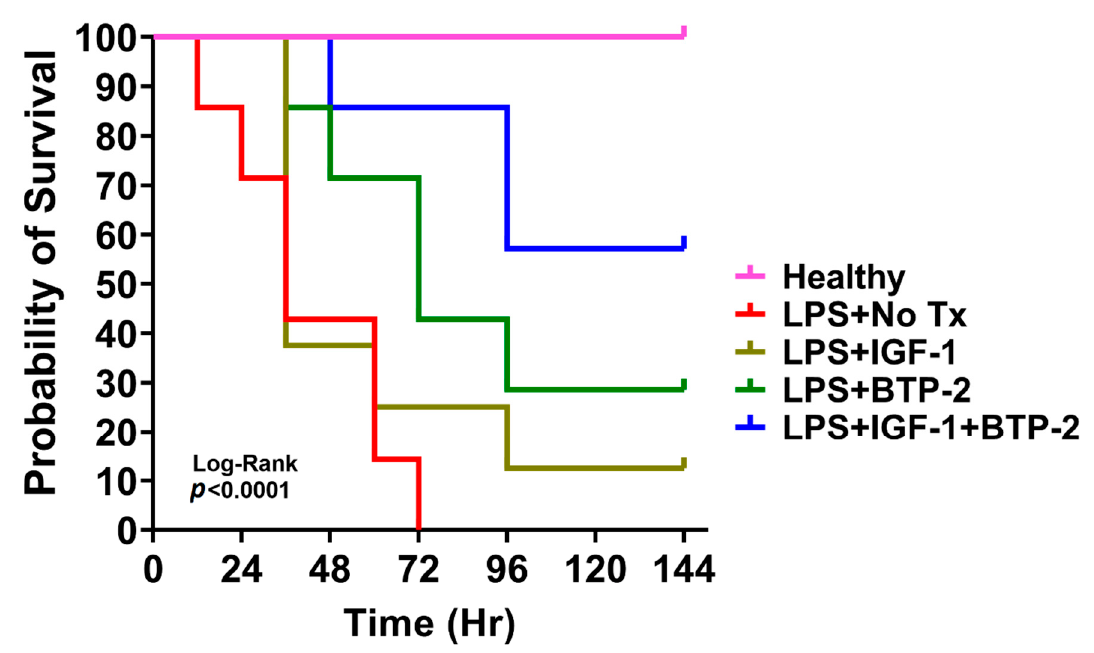
Figure 3. Overall survival of mice after the LPS injection and subsequent treatment. All of the animals except the healthy group were treated with 25 mg/kg of LPS IP. 144 h post-LPS injection, all of the surviving animals were sacrificed, and the experiment was terminated. Kaplan–Meier survival in response to LPS administration . Comparison of the trend of survival curve was done using the log- rank (Mantel–Cox) test (recommended), and **** p < 0.0001 ( n = 7 in each group)